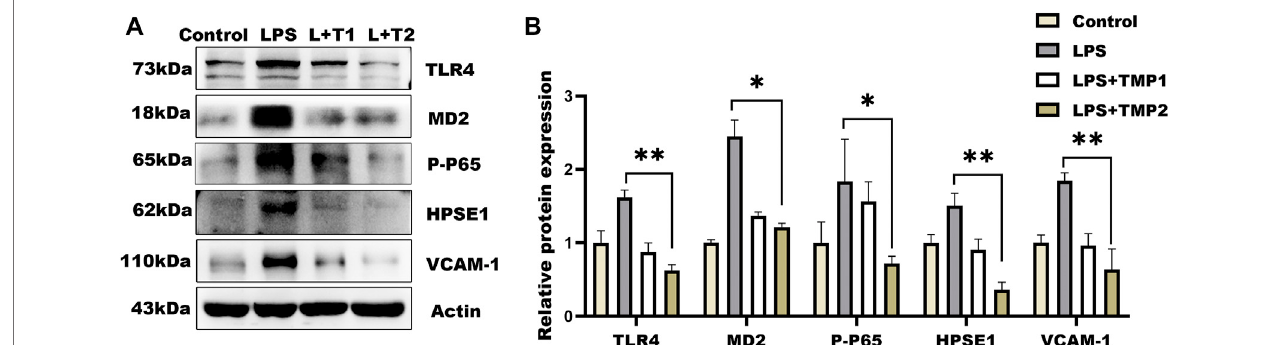
FIGURE7| EffectofTMPonglycocalyxdegradationassociatedproteinsexpression invivo .AfterintraperitonealinjectionofTMP(3 mg/kg,6 mg/kg)for7days,the mice were injected intraperitoneally with LPS (2.5 mg/kg) for 12 h (A) Expression of TLR4 Signal Axis Associated Proteins in Mouse Aorta by Western blot Analysis (B)